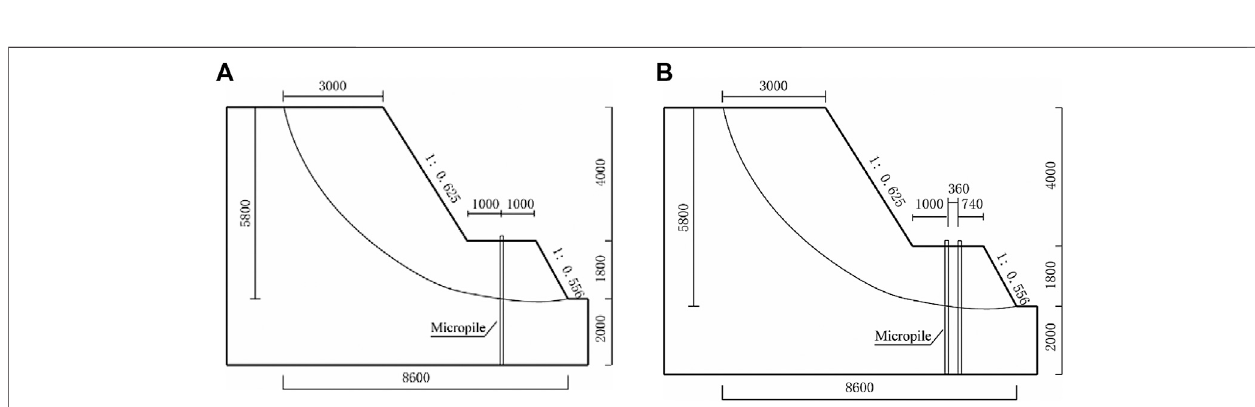
FIGURE 2 | Cross sections of the models for two con fi gurations: single row and double rows (unit: mm).